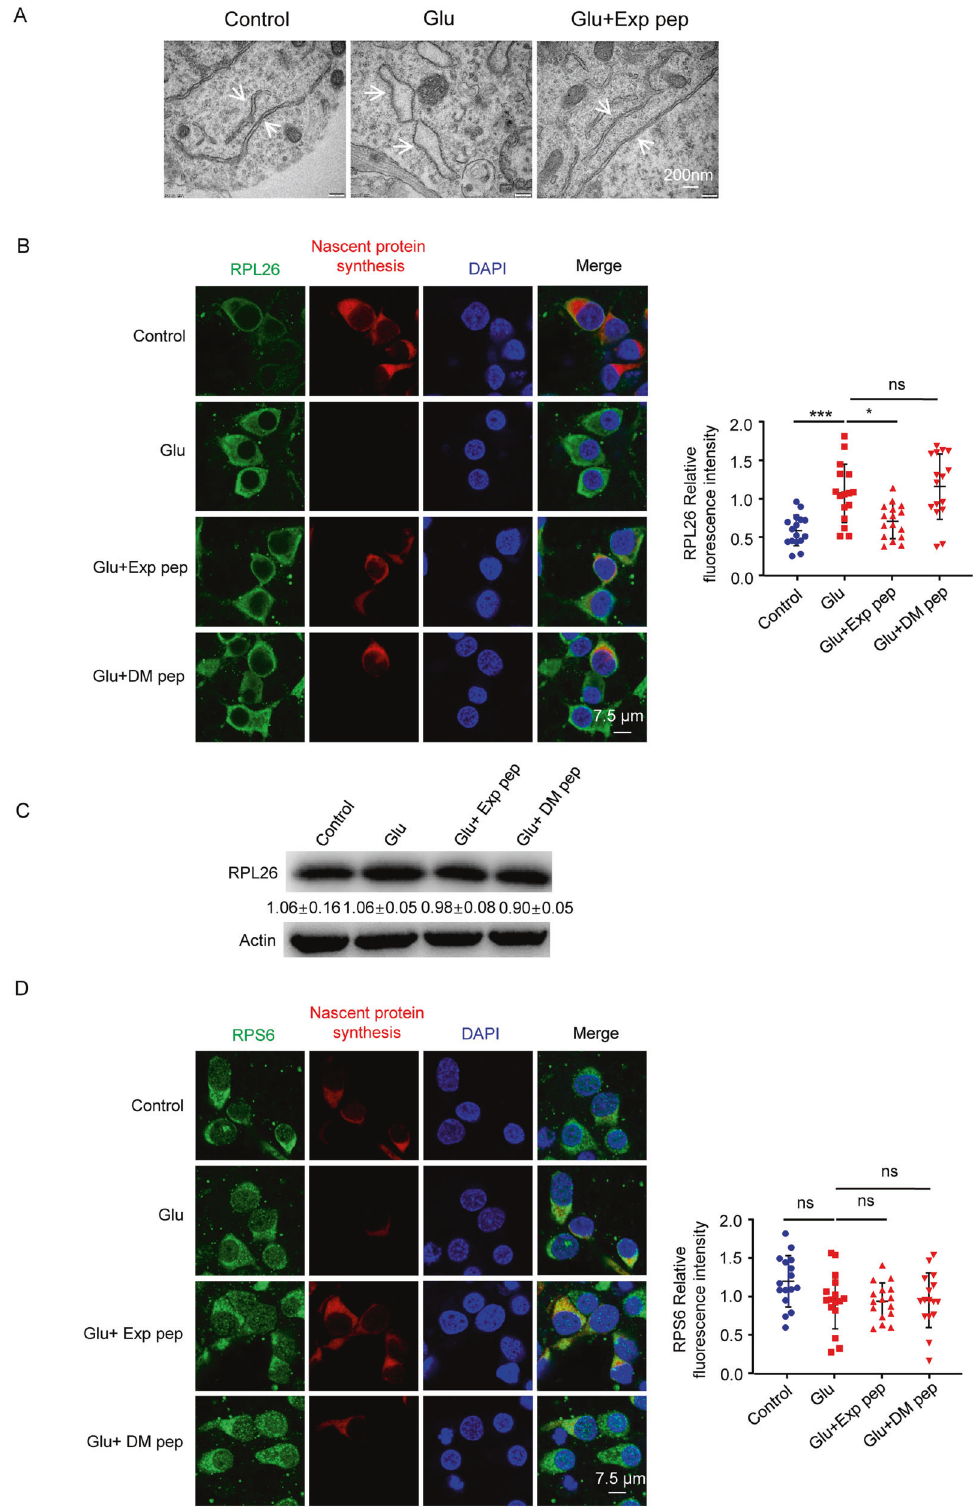
Fig. 4 Ribosomal staining pattern in neuronal necrosis. A Representative morphology of ribosome imaged by the transmission electron microscopy. Primary neurons were treated with glutamate for 30 min with or without pre-treatment of Exp pep. White arrows point to the endoplasmic reticulum. B Representative RPL26 immunostaining pattern in neurons treated with glutamate, and with or without Exp pep or DM pep pretreatment. Eight random selected fi elds were quanti fi ed for each trial. Trial n = 2. The fl uorescent intensity of each fi eld was plotted. C With or without Exp pep or DM pep pretreatment, primary neurons were treated with glutamate for 30 min. Then, total proteins were collected and the protein level of RPL26 was determined by Western blot. Trial n = 3. D With the same condition as in ( B ), the representative RPS6 immunostaining pattern in neurons. Five random selected fi elds were quanti fi ed for each trial. Trial n = 3. Cell Death and Disease (2021)